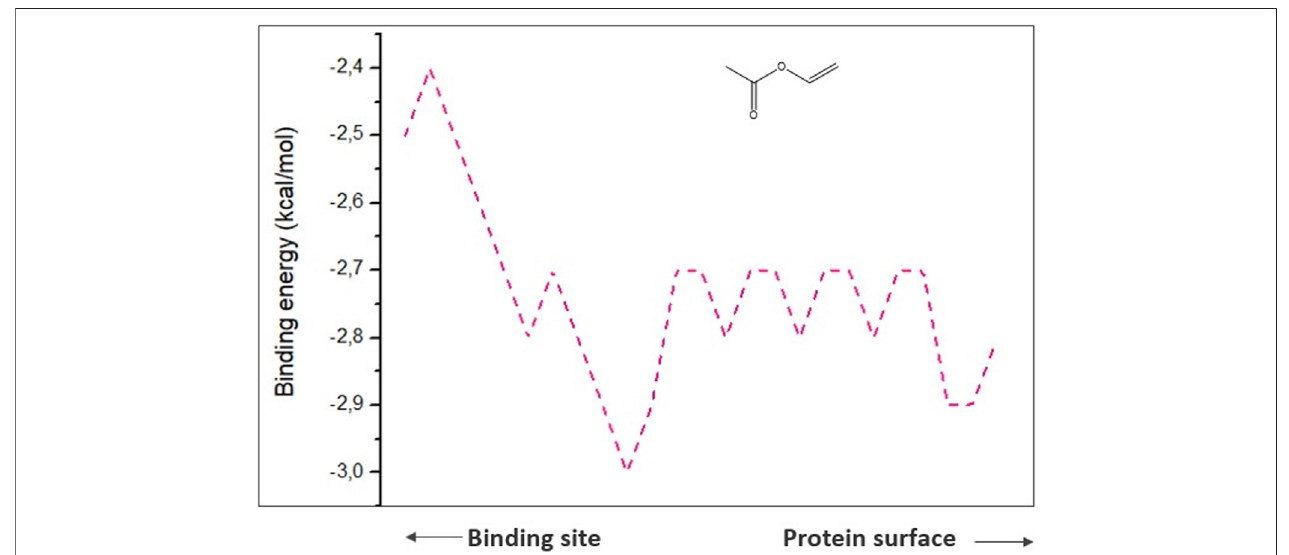
FIGURE 6 | Representation of binding energies, trajectory and tunnel radius to vinyl acetate referring to tunnel 1.